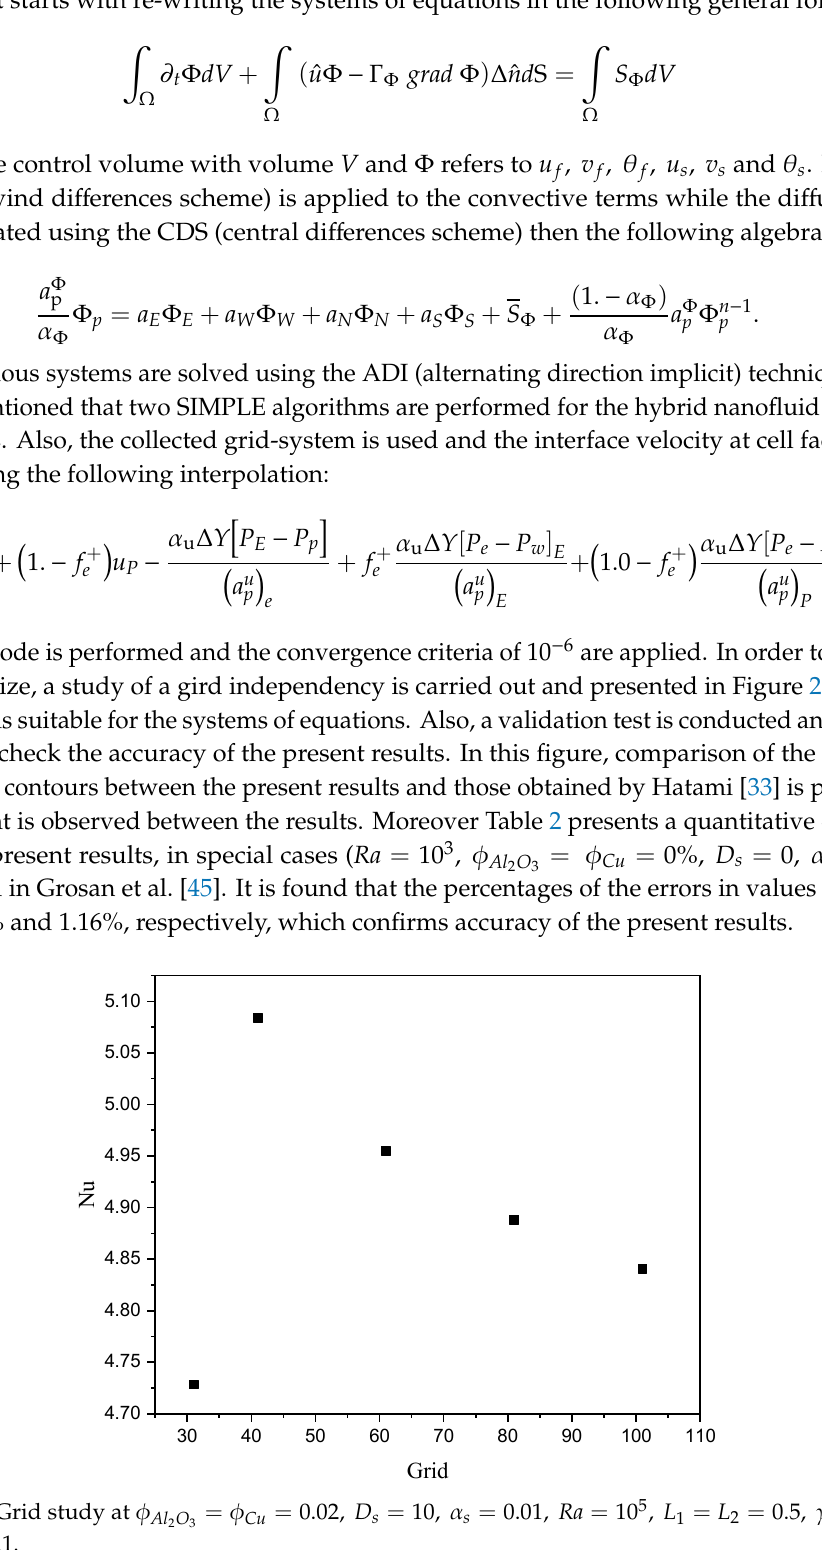
Figure 2. Grid study at φ Al and γ = 0.1 .